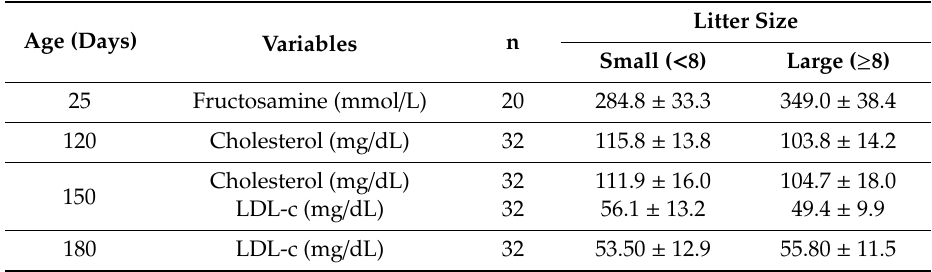
Table 1. Highlighted significant di ff erences ( p < 0.05) in metabolic parameters between piglets from large and small litters.